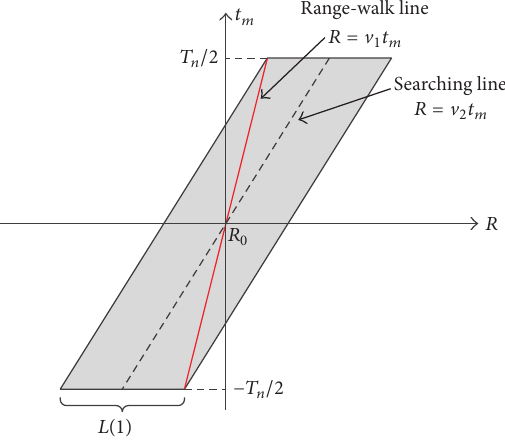
Figure 1: Sketch map of the BSSL